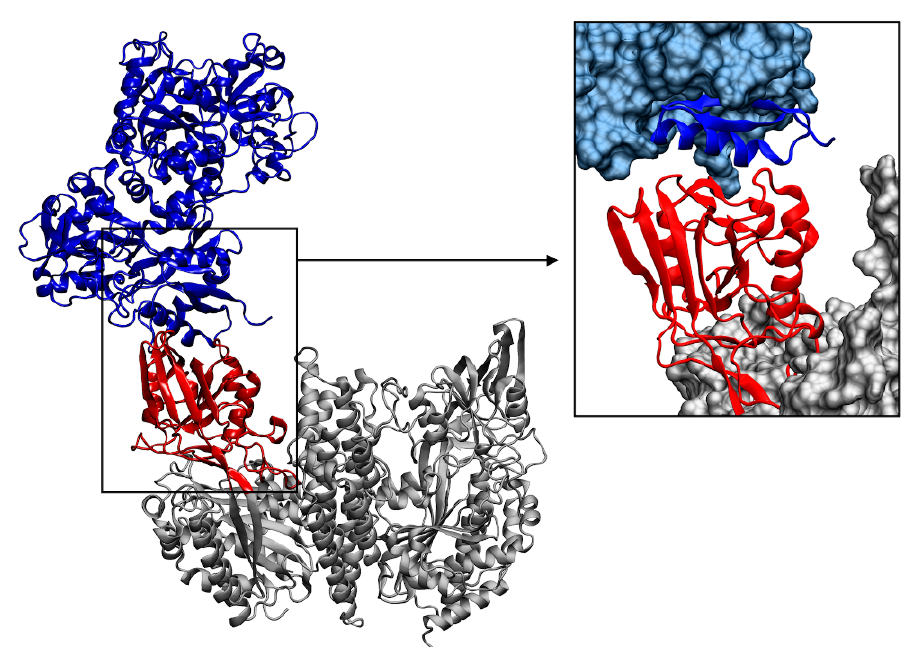
Figure 9. Complex obtained between bovine lactoferrin (bLf) (in blue) and human transferrin receptor 1 (TfR1) (in grey). The apical domain of TfR1, binding site of bLf, is highlighted in red. A closer representation of the interaction site is shown in the right image, where the proteins are represented as a solid surface, except for the interacting regions that are shown as cartoons.